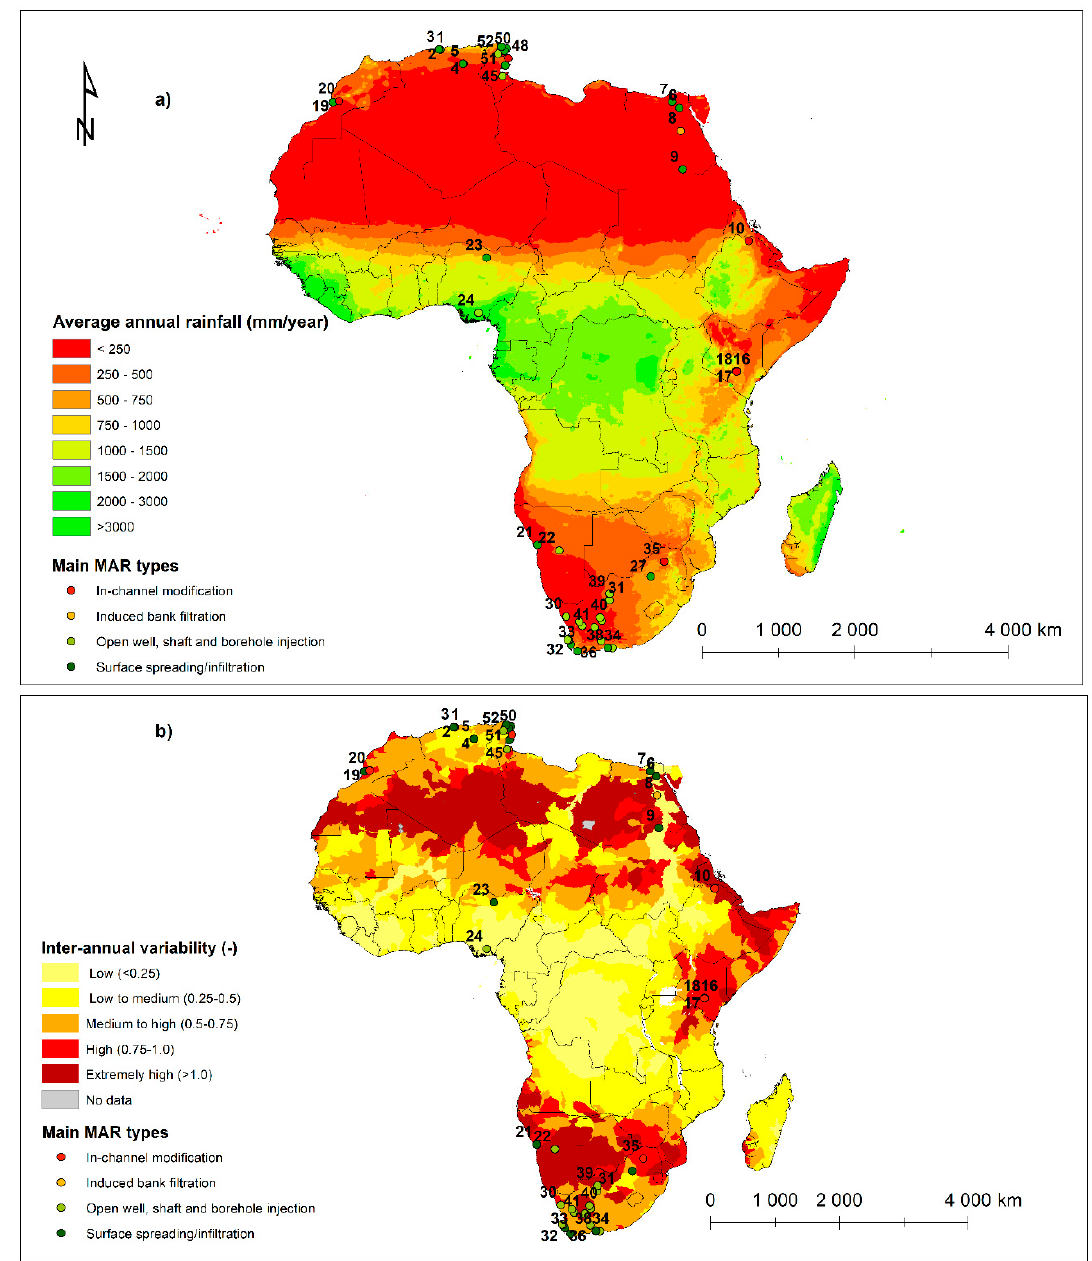
Figure 6. Location of MAR schemes in Africa overlaid on ( a ) average annual rainfall from Climate Hazards Group Infrared Precipitation with Stations (CHIRPS) [31] and ( b ) inter-annual variability in available surface water from Aqueduct Global Maps 2.1 [33]. MAR case labels corresponds to MAR cases numbering in Annex S1 and Annex S2 of the ESM